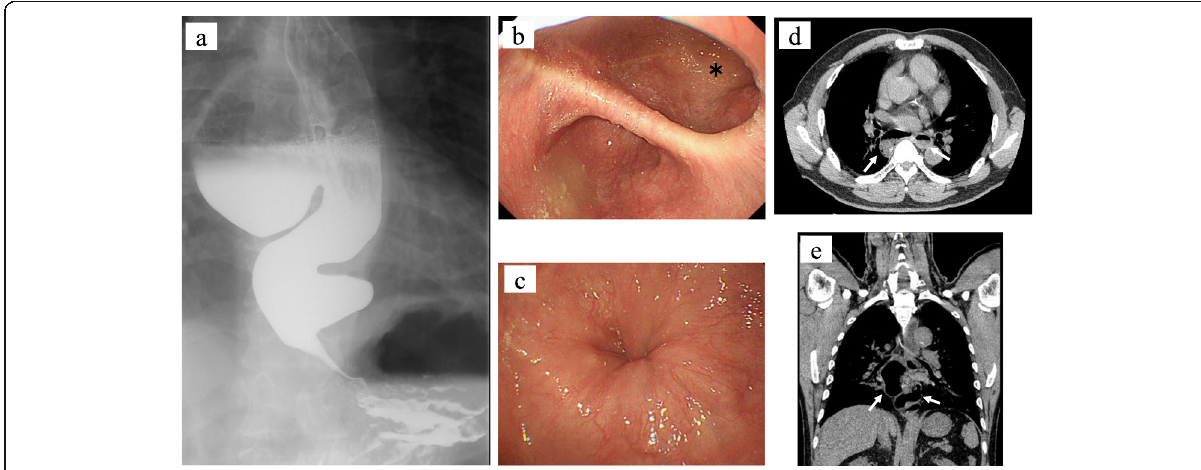
Fig. 1 Preoperative imaging findings. a An upper gastrointestinal contrast study demonstrates dilatation of the esophagus and epiphrenic diverticula. b Upper gastrointestinal endoscopy shows a huge diverticulum in the lower esophagus ( asterisk ). c Endoscopic examination showed that the rosette-like esophageal folds appeared in the lower esophagus. d , e Chest computed tomography demonstrates dilatation of the esophagus and the epiphrenic diverticula of 50×40 mm and 25×25 mm in size. Arrows indicate the